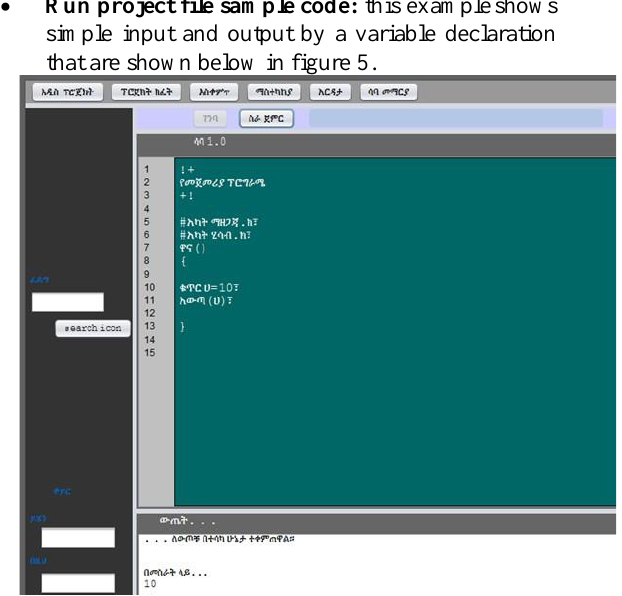
• Compilation error: when a program is loaded and an error is generated during the compilation process. This error is shown in below figure 6.